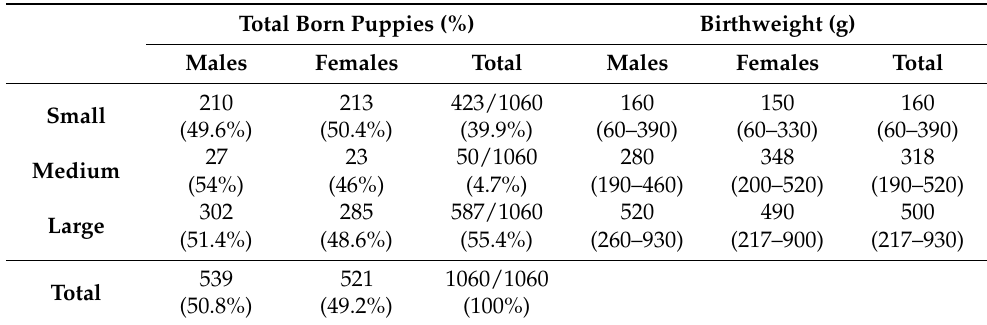
Table 3. Data about the total born puppies (total number, males and females), and about birthweight, with puppies grouped according to BBS. Data regarding birthweight are expressed as a median (min–max).